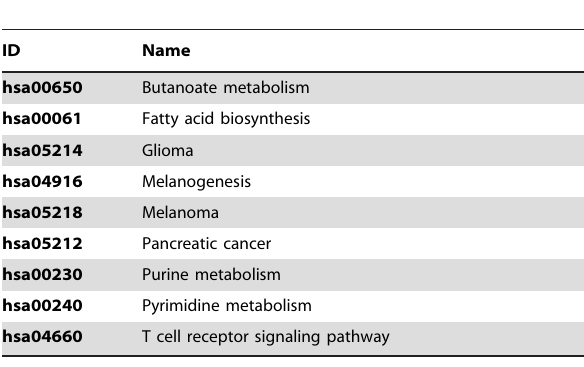
Table 4. Significant pathways identified by the improved BPA system using the NCI-60 microarray data set on samples with and without p53 mutation (p53 + : 17 Samples, p53 2 : 33